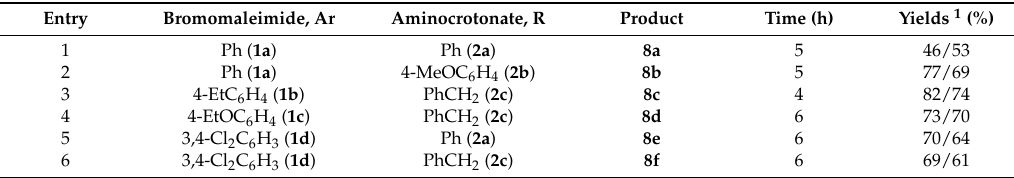
Table 1. Reaction of 1 with 2 .